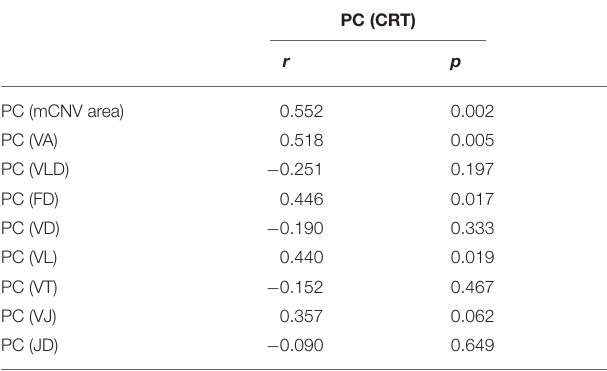
TABLE 4 | The correlation analysis between the percent change of central retinal thickness and quantitative OCTA-based biomarkers in myopic choroidal